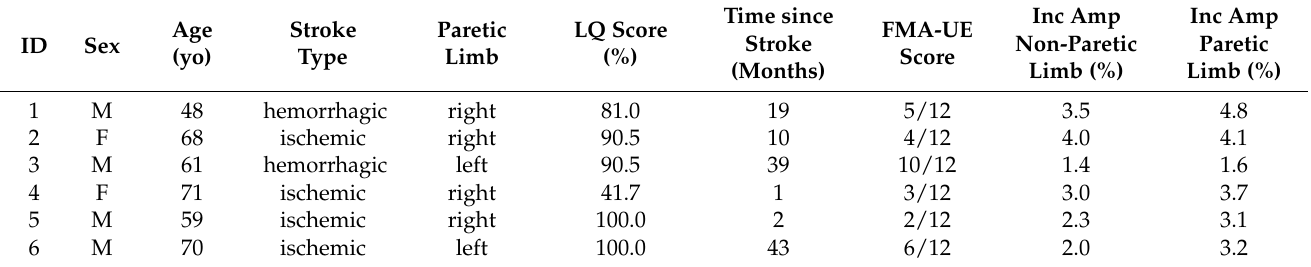
Table 1. Demographic, clinical data, and increment amplitude values of the evaluated stroke